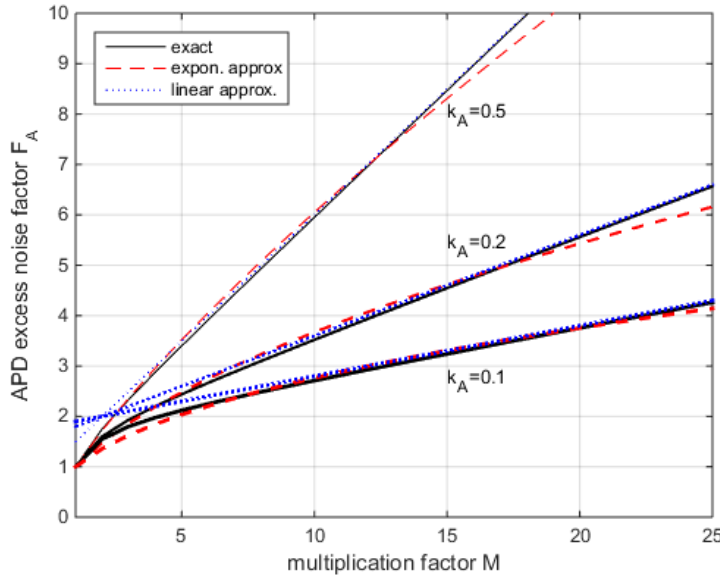
Figure 2. Comparison of approximations (5) and (6) with exact solution (4).